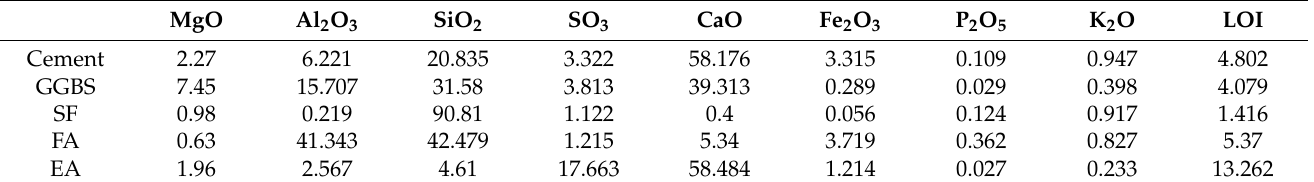
Figure 2. Particle size distribution and cumulative curve distribution of materials.